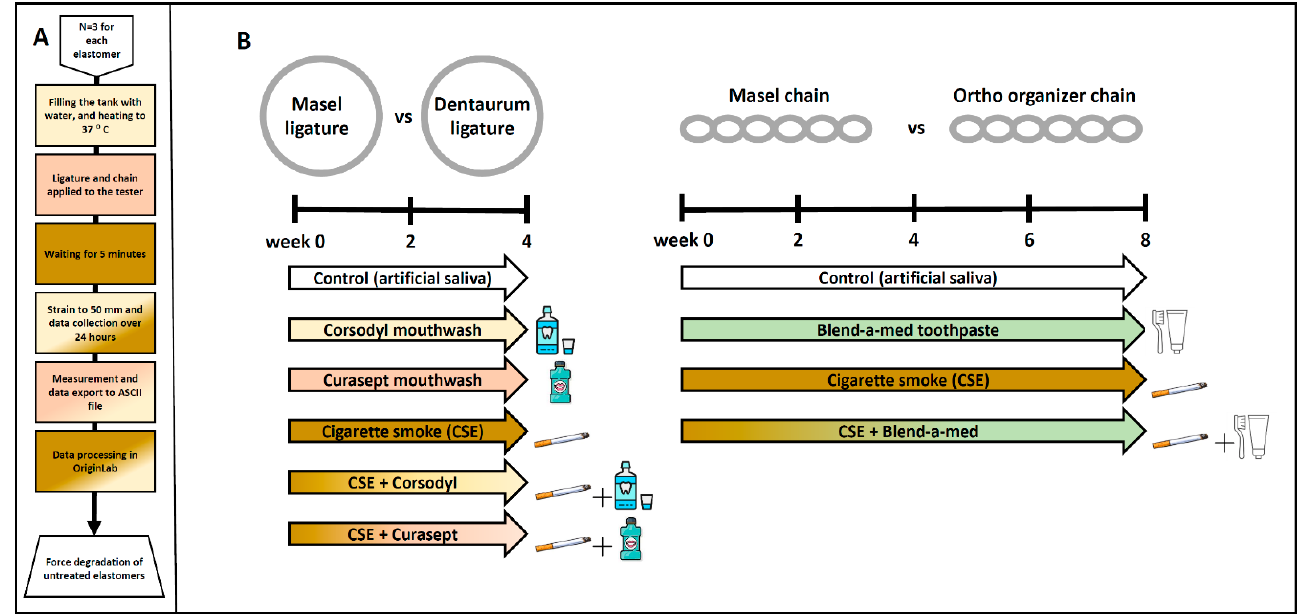
Figure 2. ( A ) Schematic diagram of force degradation measurement protocol, in case of untreated elastomers. ( B ) Experimental protocol for measuring force degradation of Masel and Dentaurum ligatures, as well as Masel and Ortho organizer chains due to chemical and mechanical plaque con- trol.